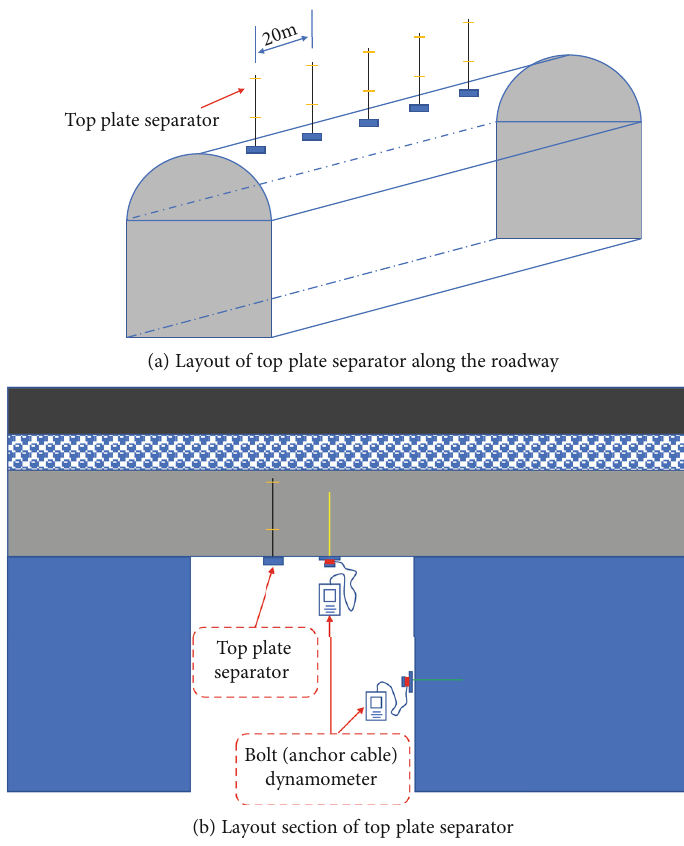
Figure 4: Arrangement of measuring points of top plate separator.